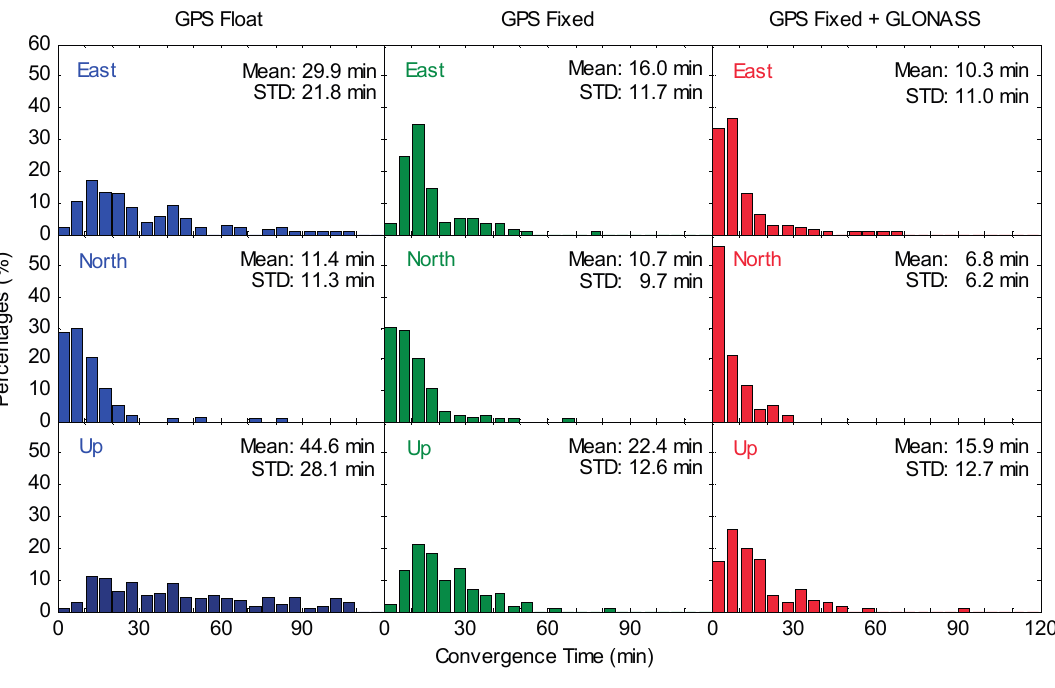
Figure 9. Distributions of convergence time for GPS ambiguity-float PPP, GPS ambiguity-fixed PPP and GGPPP-FGA processing in eight sessions using datasets collected at 20 IGS stations on two consecutive days. The distributions in the east, north and up components are displayed in the top , middle and bottom panels, respectively. The criterion of convergence is defined when the positioning errors reach 0.1 m and keep within 0.1